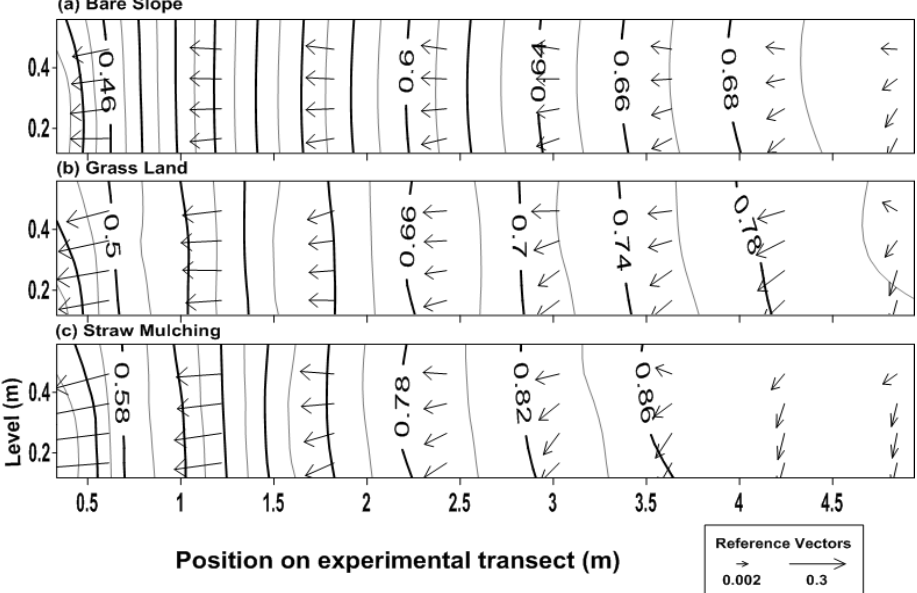
Figure 14. Flow field of the groundwater after termination of the rainfall for three scenarios: ( a ) Bare Slope; ( b ) Grass Land; ( c ) Straw